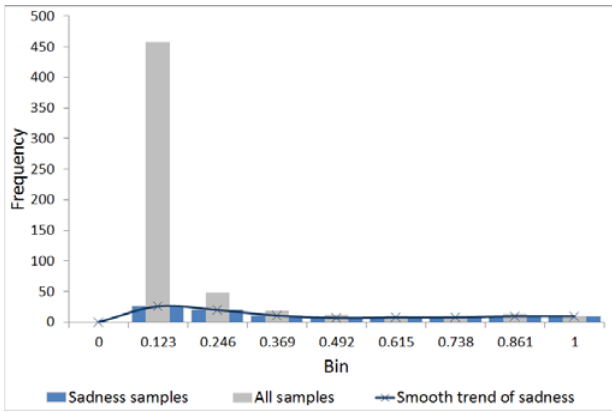
Figure 6. Histogram of sadness and all